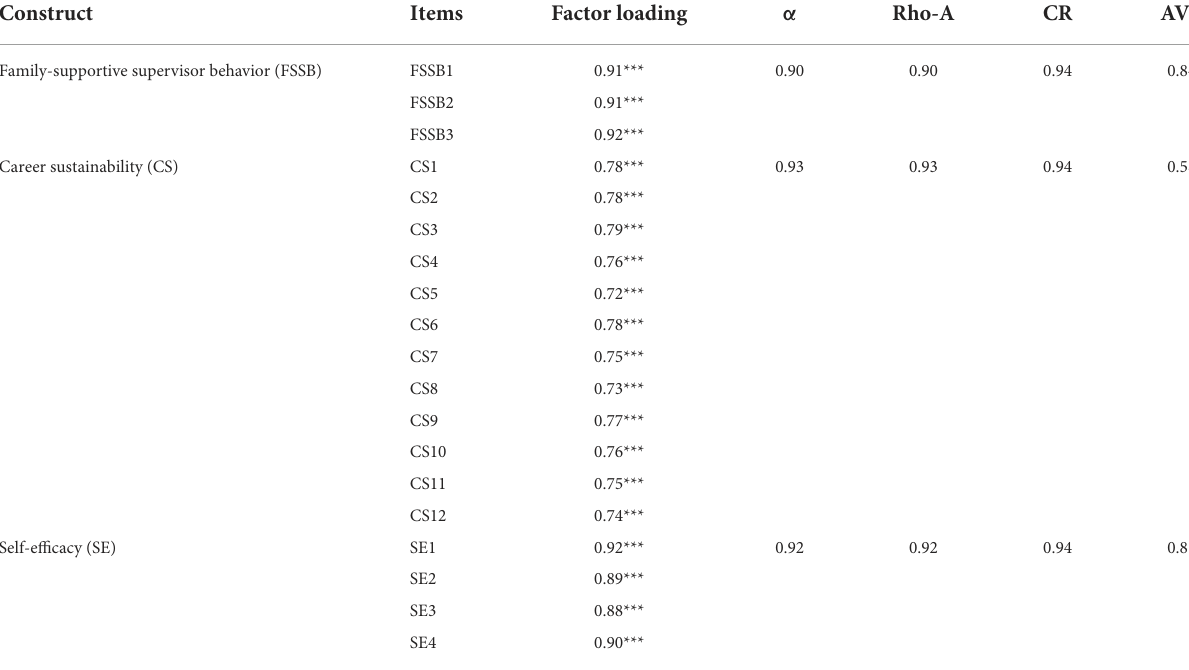
TABLE 2 Analysis results of factor loading, Cronbach’s alpha, composite reliability, and AVE.